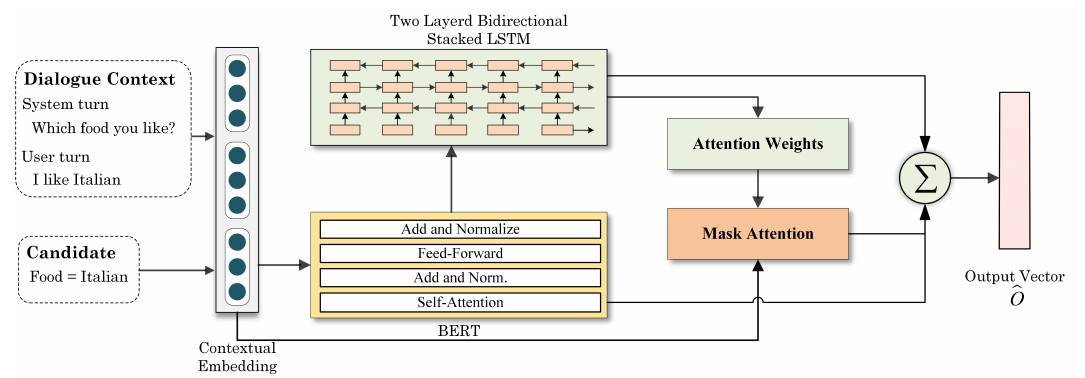
Figure 4. A schematic view of the proposed